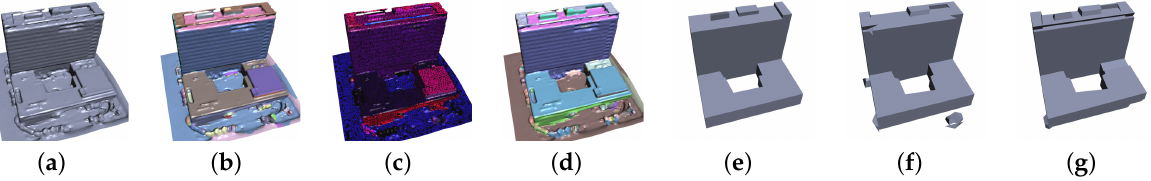
Figure 13. Comparison with other methods of segmentation and polyhedral models: ( a )